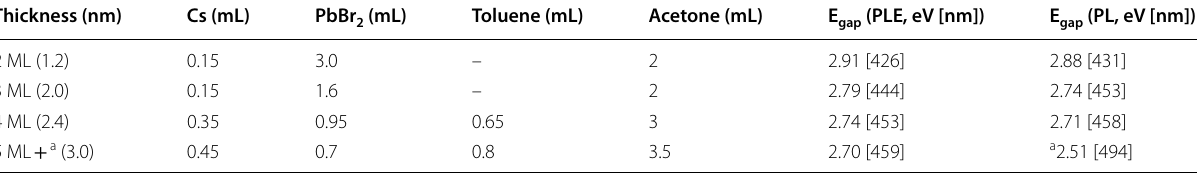
nanoplatelets synthesized at room 3